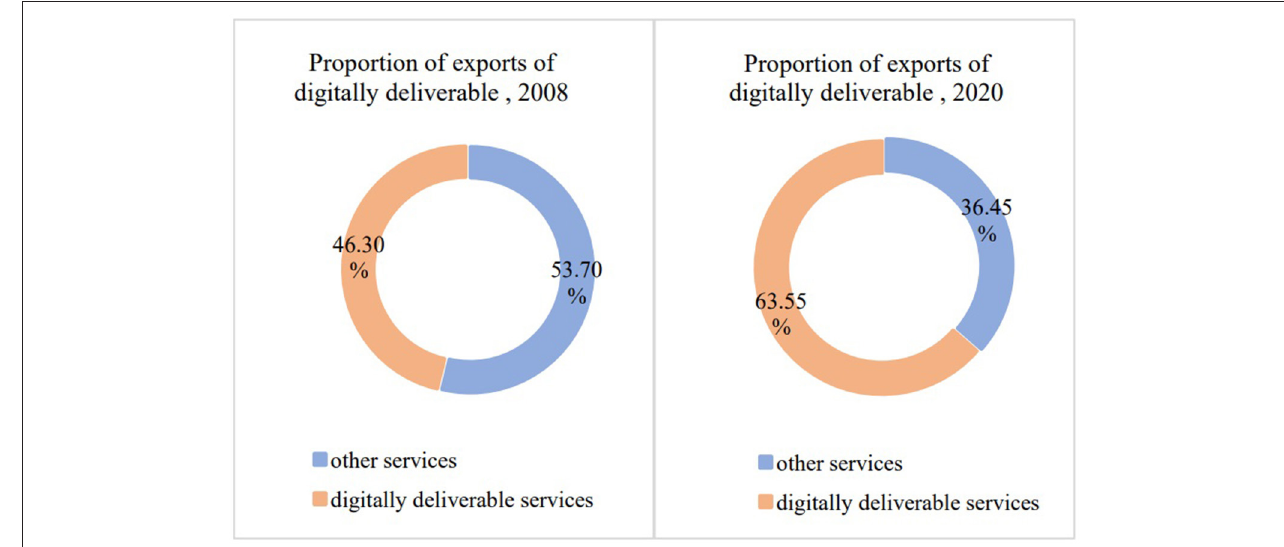
FIGURE 2 | Proportion of exports of digitally deliverable services, 2008 and 2020.